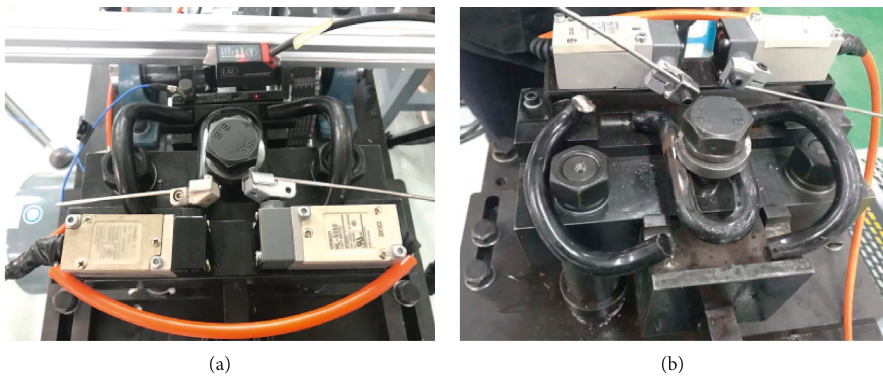
Figure 17: ω -type clip broken after